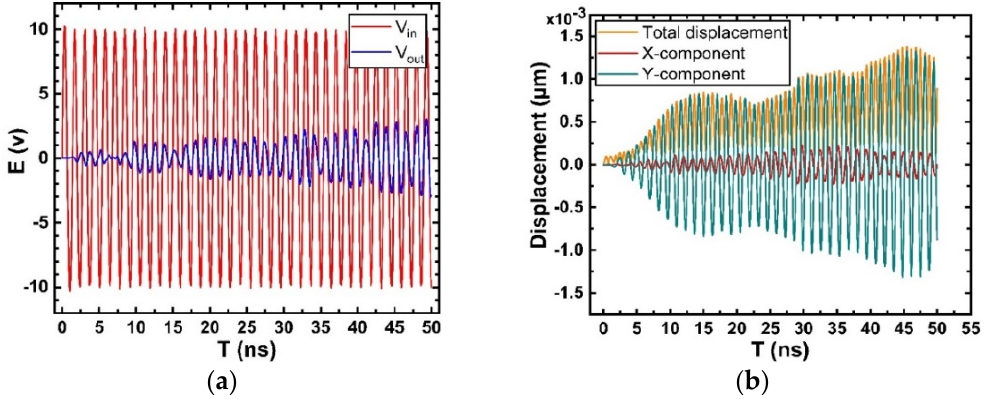
Figure 19. Results of transient analysis. ( a ) Input and output voltage on IDT; ( b ) Simulation diagram of the total surface displacement of the model and its X-Y component displacement.